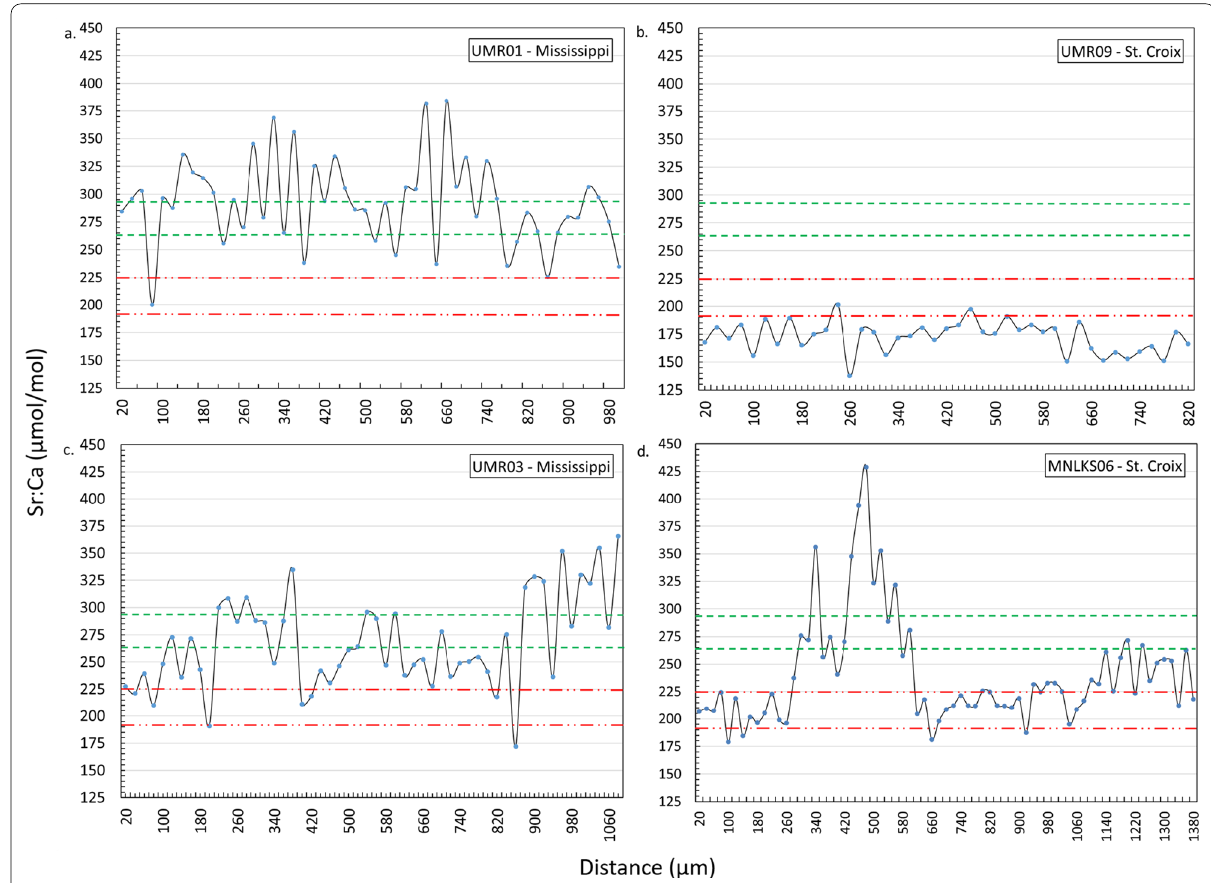
Fig. 10 Pectoral fin ray transect data for individual lake sturgeon from the Mississippi ( a , c ) and St. Croix ( b , d ) Rivers that demonstrate low ( a , b ) and high ( c , d ) migratory variability throughout the life of the fish. Green dashed lines and red dashed and dotted lines represent 95% confidence intervals for “edge” data that represent capture location from sturgeon captured in the Mississippi and St. Croix Rivers, respectively. Fish identifiers included in each figure panel (UMR01, UMR09, UMR03, MNLKS06) correspond to fish identifiers used in laser ablation data presented in Additional file 3 and Zigler et al.